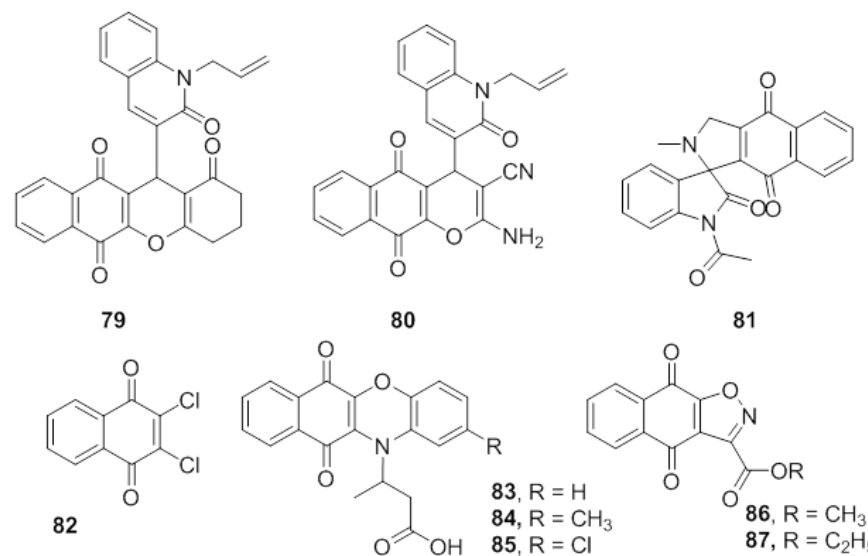
Figure 6 - a (Entry 79 – 81) – Examples of 1,4-benzoxanthenes with antifungal activity; b (Entry 82 – 87) – 1,4-Naphthoquinones fused to isoxazoles or phenoxazins with antifungal